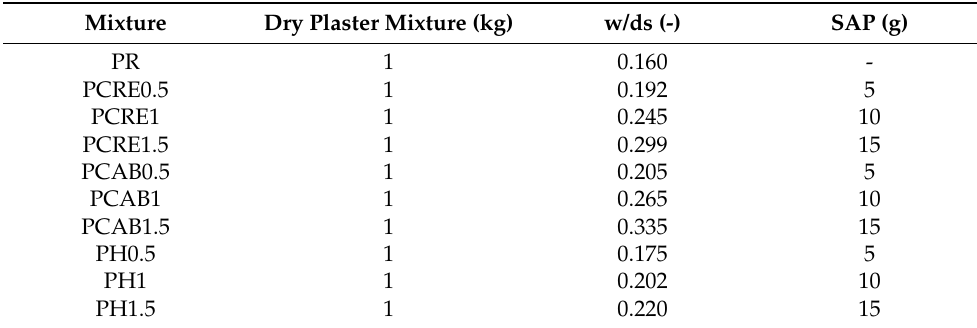
Table 2. Composition of studied plaster mixture—reference plaster—PR, plasters with Creasorb SIS—PCRE, Cabloc CT—PCAB, and